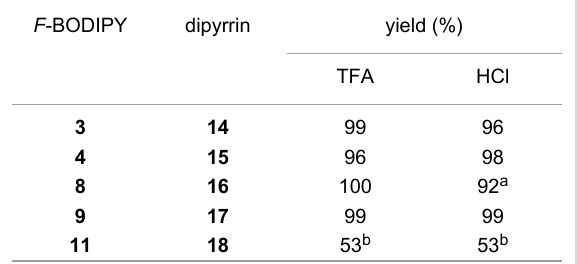
Table 1: Removal of BF 2 from F -BODIPYs using Brønsted acids. F